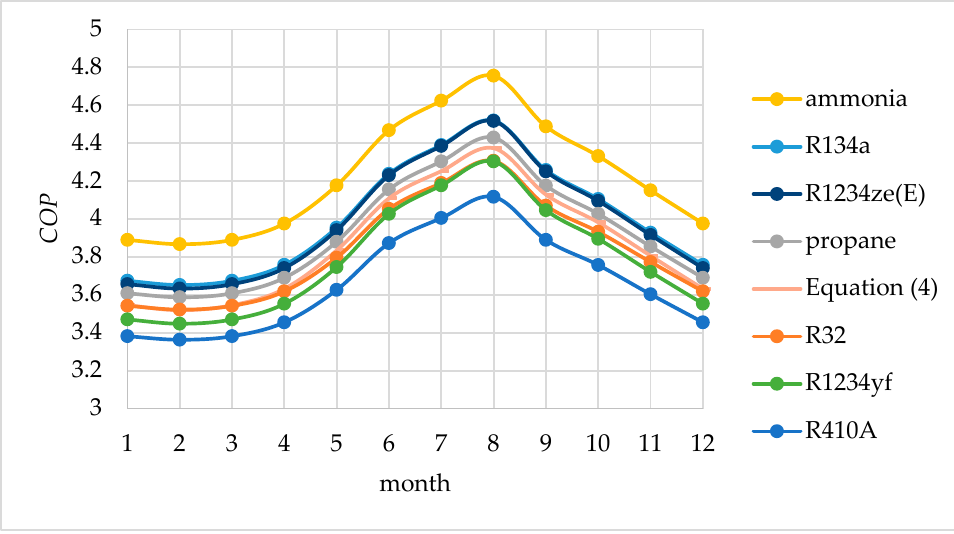
Figure 7. COP variation of a heat pump with selected refrigerants over a year. Additionally, the COP calculated from Equation (4) was also shown in Figure 7. The obtained results are within the average value of COP for different refrigerants. Hence, Equation (4) can be used as a general prediction of the COP variability for further analysis. Heat recovery was considered for the following locations along the technological process of the Mokrawica WWTP (Figure 1): (A) sand box, (B) aeration chamber, (C) sec- ondary sedimentation tank, and (D) treated sewage disposal. In these places, the heat re- covery potential ( Q hr ) was determined from Equation (1). Calculations were made for the minimum values of wastewater temperature ( t min ) and flow ( V min ) recorded in the consid- ered period. It was assumed that as a result of recovery, the wastewater can be cooled down to 8 °C. The input data and results are in Table 3.